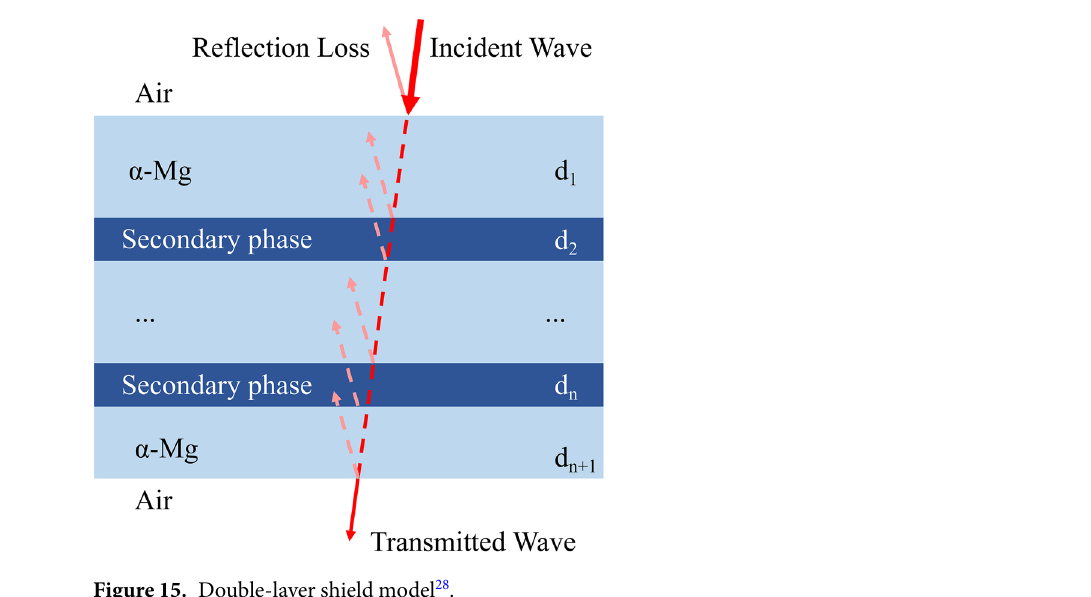
Figure 14. Schematic of secondary-phase orientation: ( a ) Mg-Zn and ( b ) Mg-Sn.